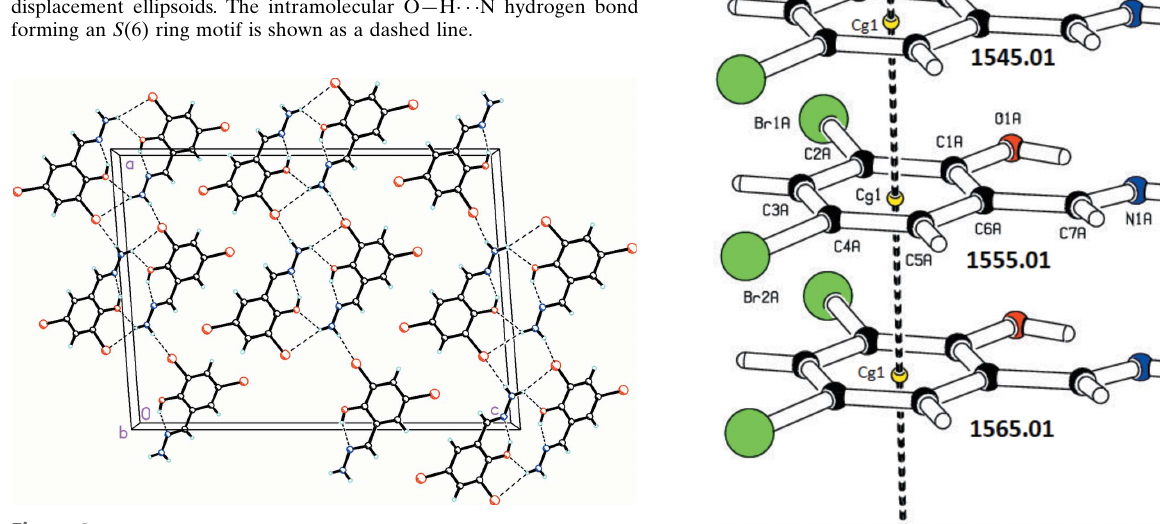
Figure 2 The crystal packing of the title compound, viewed along the b axis. Dashed lines indicate intermolecular N—H (cid:2)(cid:2)(cid:2) Br and N—H (cid:2)(cid:2)(cid:2) O hydrogen bonds.